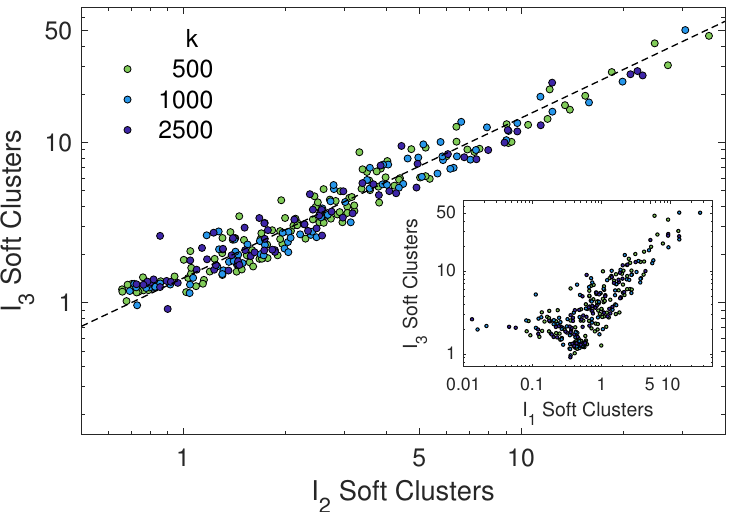
Figure 7. Correlation between the two largest eigenvalues of the inertia tensor. The dashed curve is the best-fit with the straight line I 3 = α × I 2 , α = 1.43 ± 0.03 (Pearson correlation coefficient r = 0.97). Inset: Correlation plot of the largest and the smallest eigenvalues of the inertia